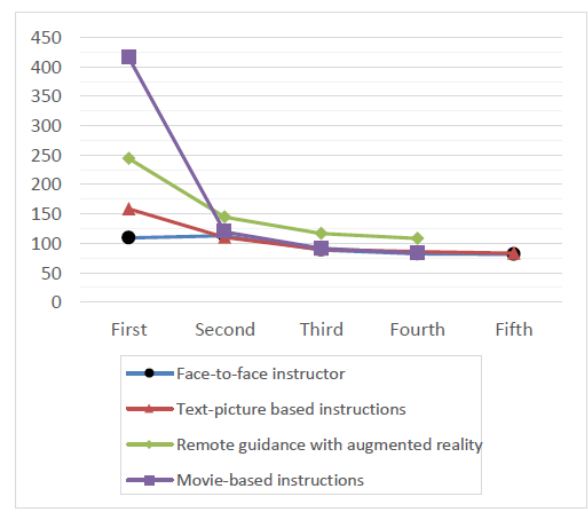
Figure 3: Graph showing development of assembly time for each support tool [11].